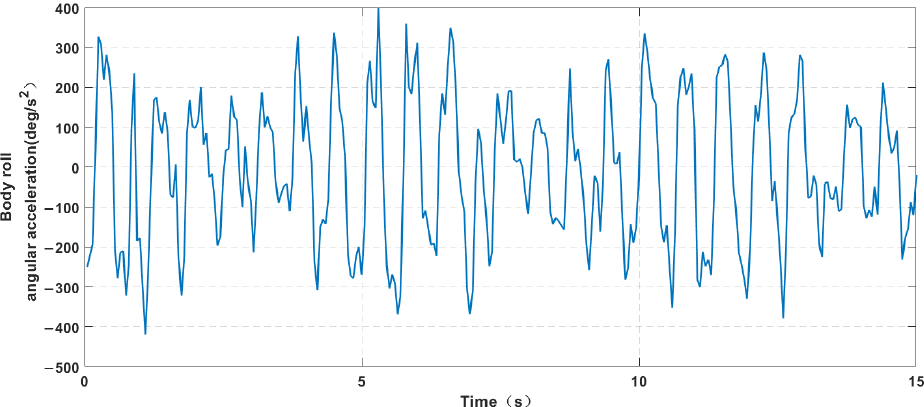
Figure 21. Experimental results: Angular acceleration of roll output from IMU of the prototype.